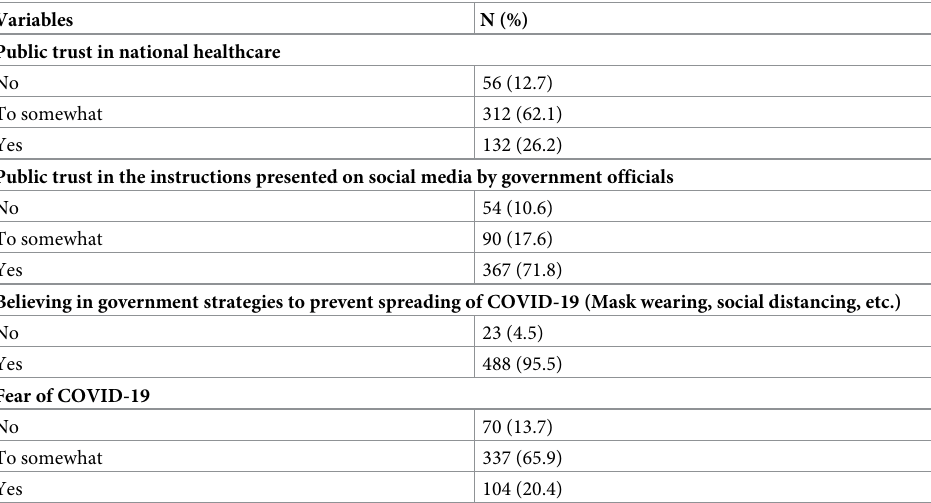
Table 1. Public trust in national healthcare, instructions given by officials on social media, government strategies to prevent spreading of COVID-19, and fear of COVID-19 among 511 participants. Variables N